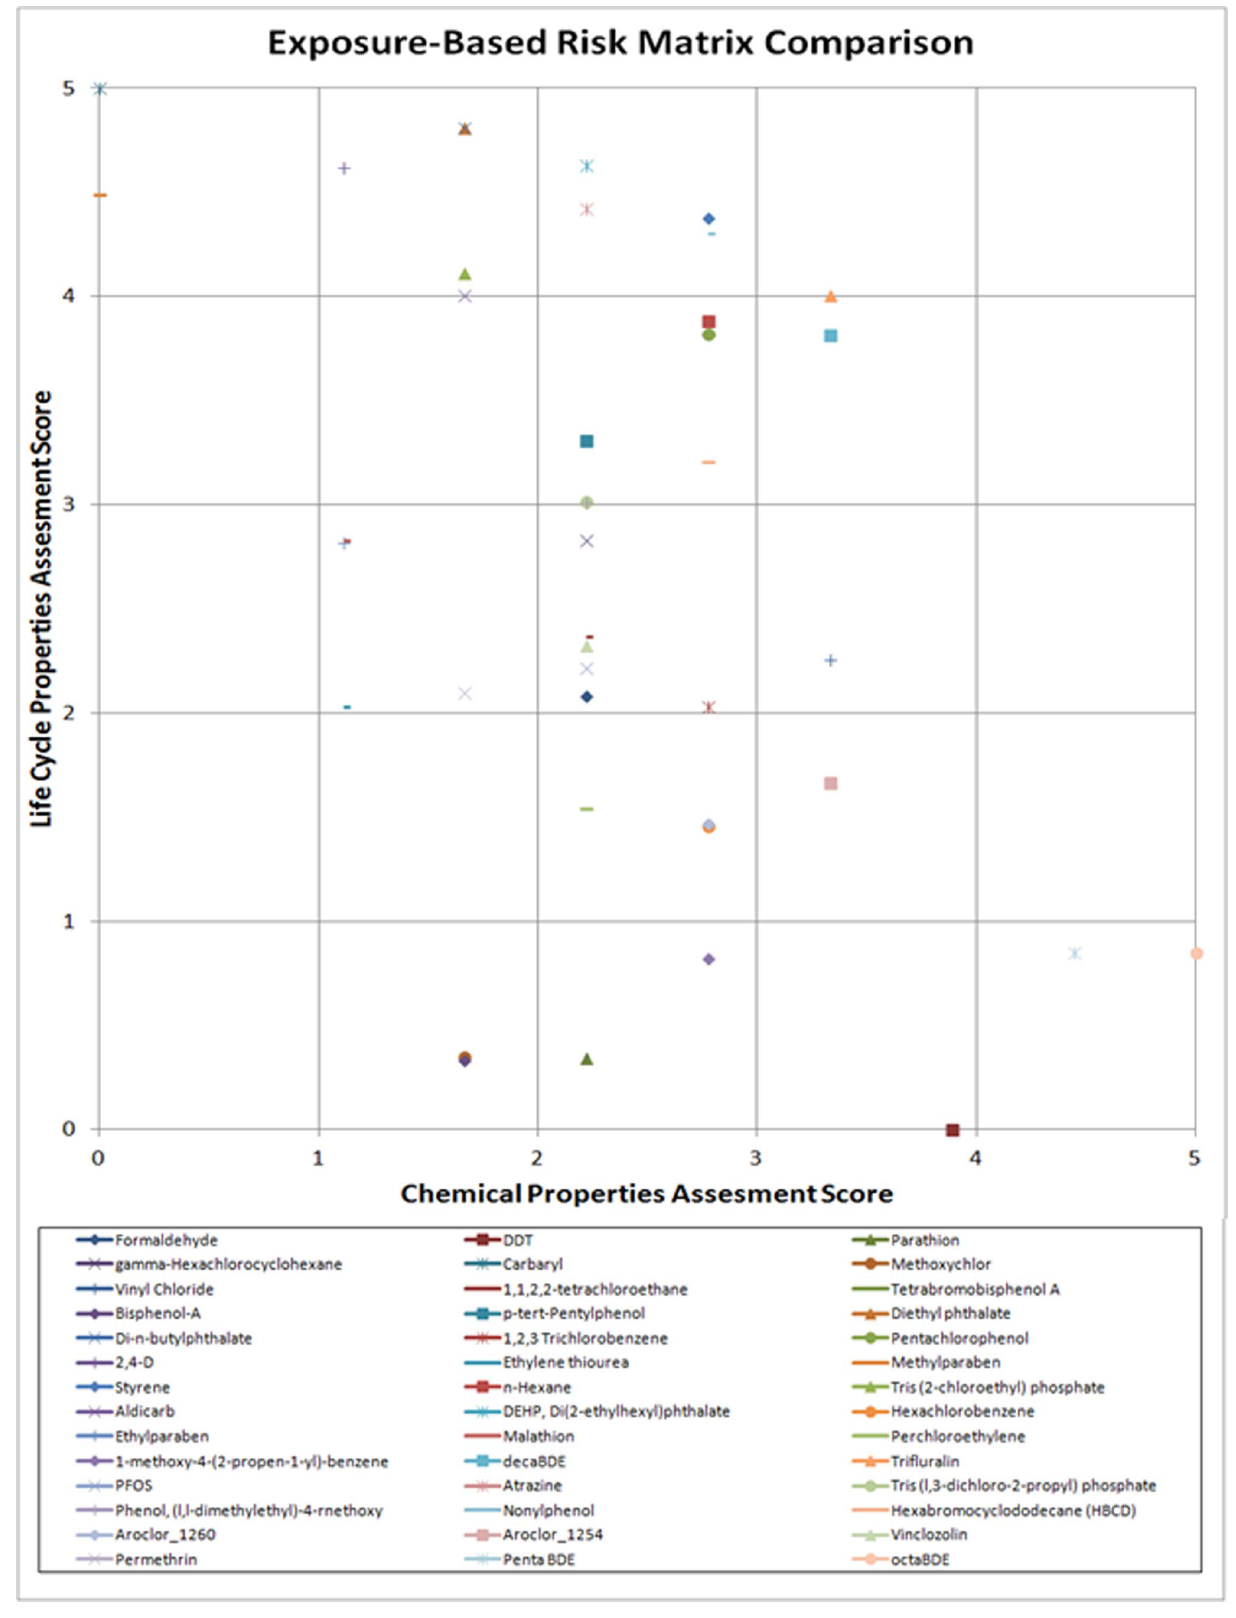
Figure 3. Risk Matrix Comparison of Exposure Potential with Even Weighting.